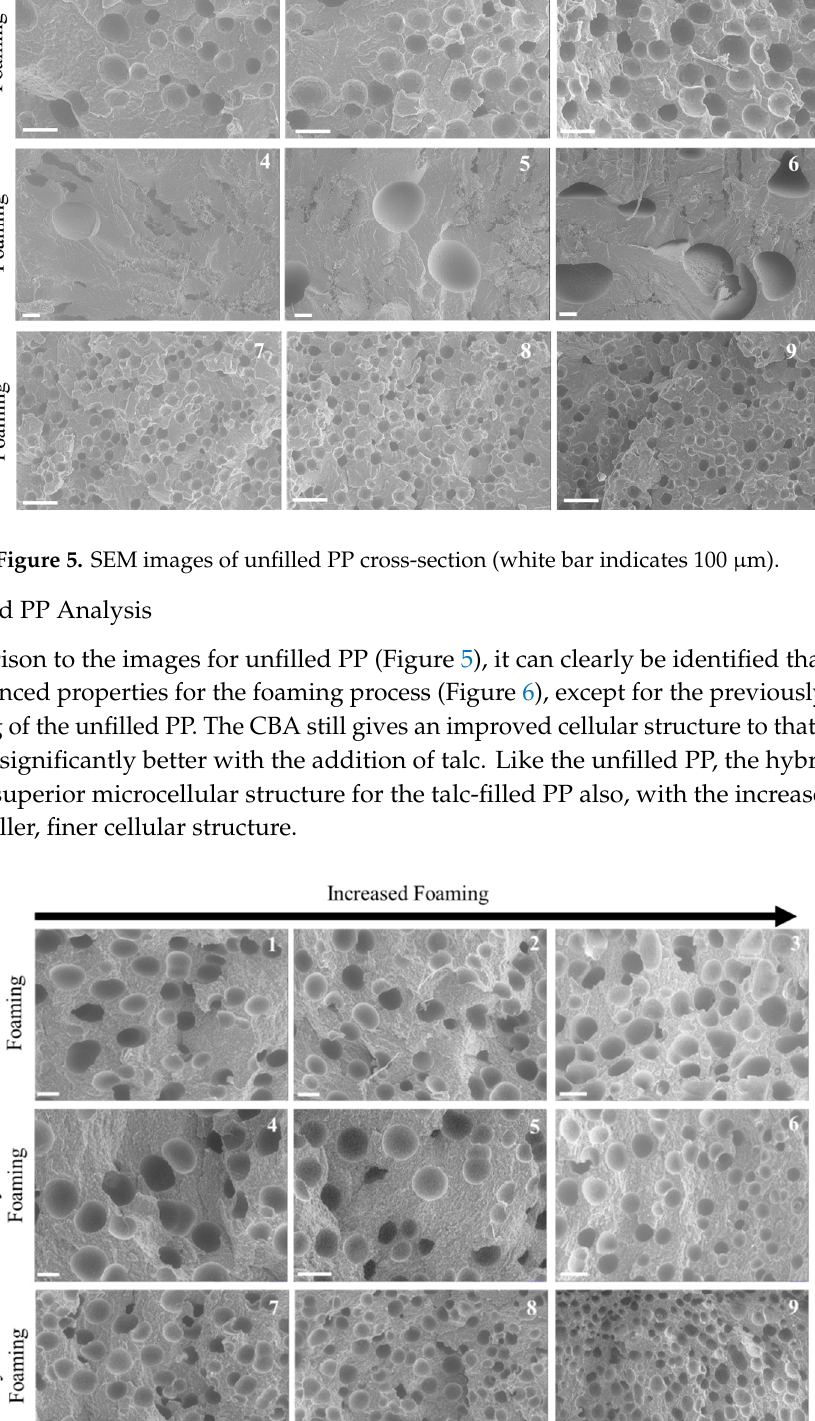
Figure 6. SEM images of talc-filled PP cross sections (white bar indicates 100µm).